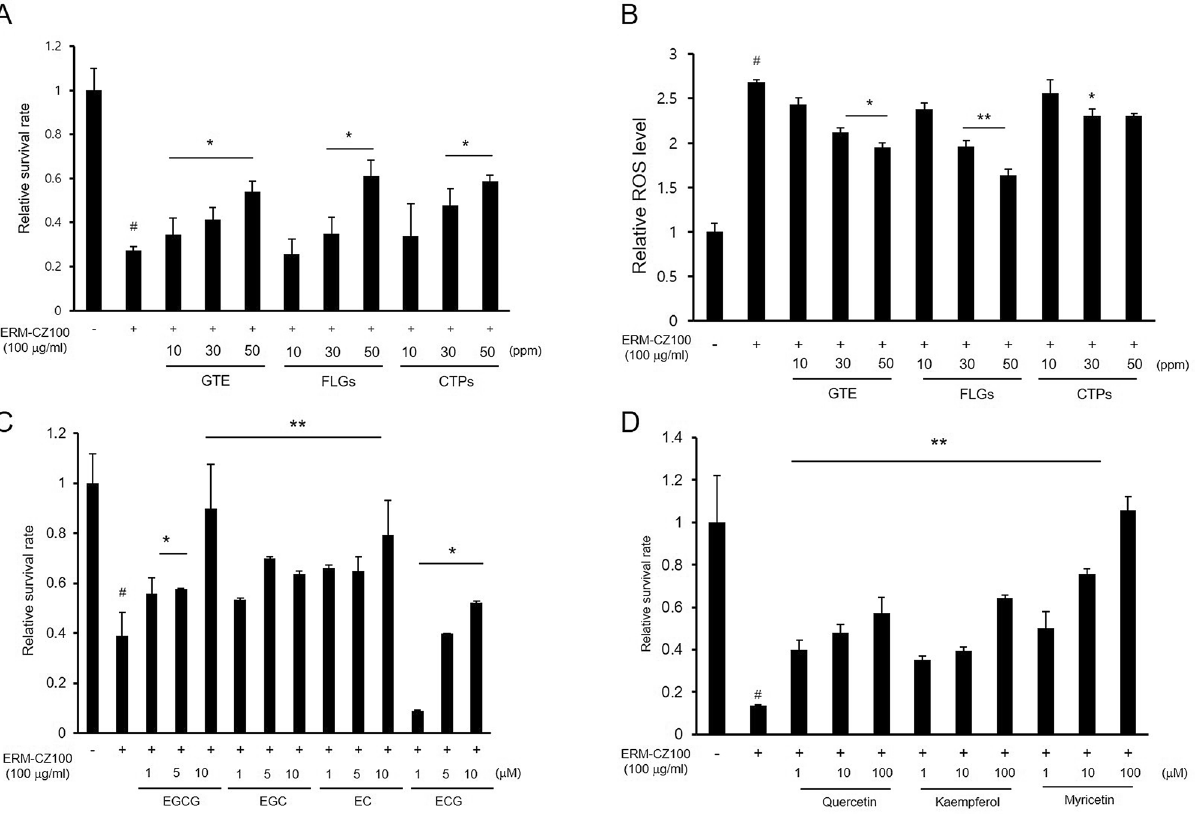
Figure 2. Protective effects of GTE, FLGs, and CTPs and their bioactive components against FDP-induced damage. ( A ) Protective effects of GTE, FLGs, and CTPs against FDP-induced cell death. ( B ) Relative ROS levels in FDP-stimulated cells treated with GTE, FLGs, and CTPs. ( C ) Protective effects of green tea catechins against FDP-induced cytotoxicity. ( D ) Effects of green tea flavonols on the relative survival rates of FDP-treated cells. Cell viability was measured by MTT assay, and intracellular ROS levels were investigated by DCF-DA assay. All results are expressed as the means ± SDs of the values obtained in 3 independent experiments (N = 3). * p < 0.05 and ** p < 0.001 compared to the FDP-treated group; # p < 0.001 compared to the vehicle-control